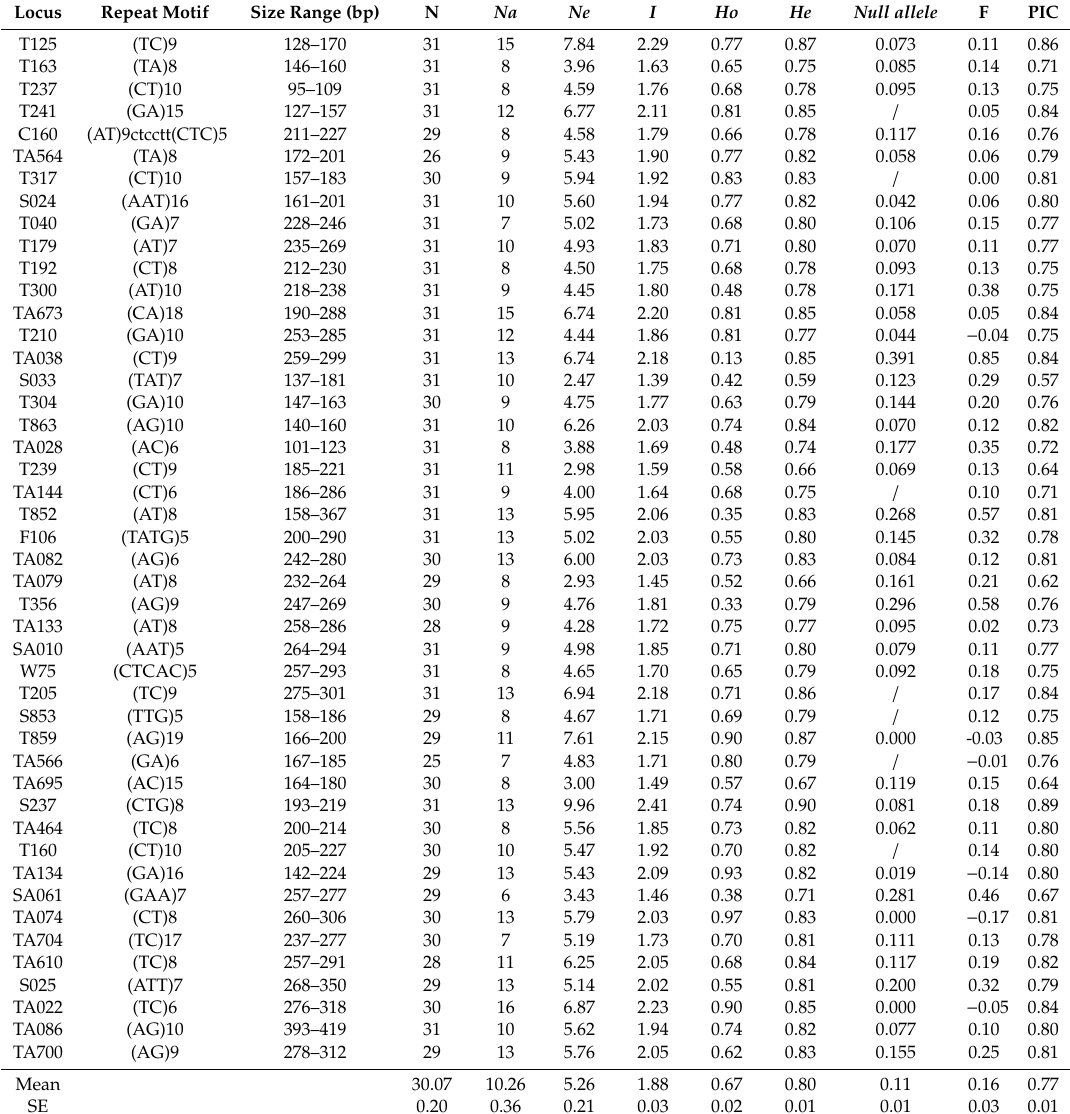
Table 1. Size range of amplification products, sample size (N), the frequency of null allele at locus (Null allele), number of di ff erent alleles (Na), number of e ff ective alleles (Ne), Shannon’s information index (I), observed heterozygosity (Ho), expected heterozygosity (He), fixation index (F) and polymorphism information content (PIC). / means we did not calculated the frequency of null allele at the locus because there was no significant di ff erence in the observed and expected value in this locus and it followed Hardy-Weinberg equilibrium (Chi-Square tests, p <